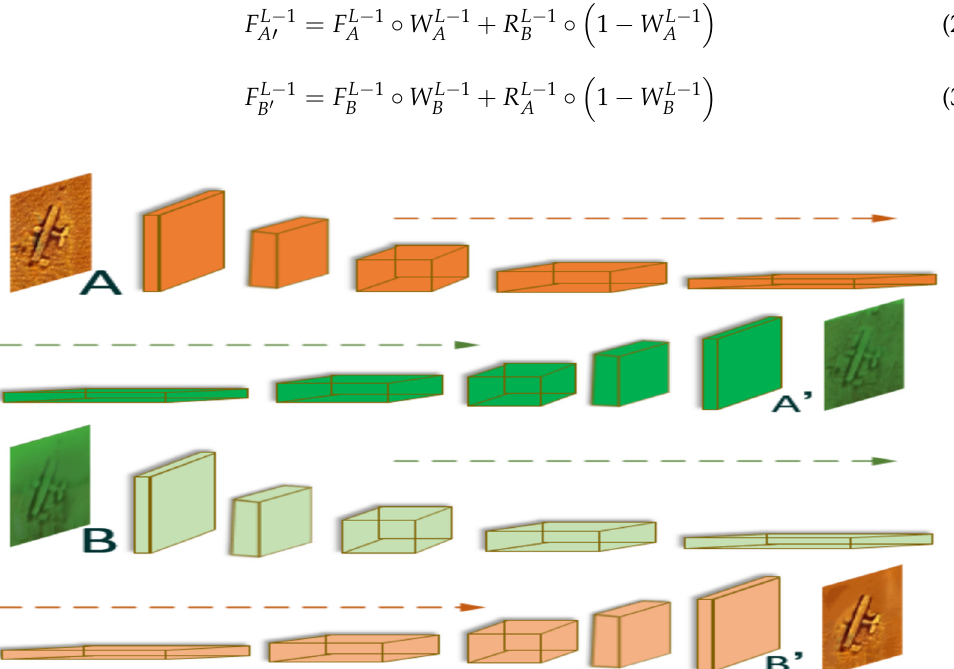
Figure 4. The image reconstruction process.